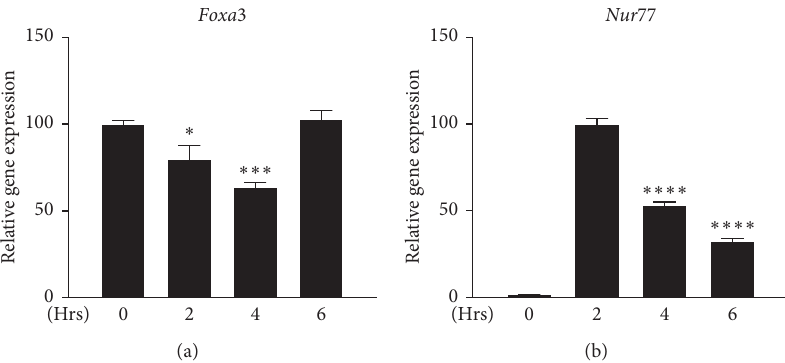
Figure 1: Expression of Foxa3 mRNA decreases during cAMP induction in MA-10 Leydig cells. Time-dependent expression of Foxa3 decreases up to 4 hours and is restored at 6 h (A), whereas the expression of Nur77 is strongly induced at 2h and then decreases (B) in cAMP-induced MA-10 cells. Nur77 expression at 2h and Foxa3 expression at 0h were considered 100% for relative comparison. The gene expression level was normalized to that of β -actin. For statistical significance, the t -test has been performed. ∗ P < 0 . 05; ∗∗ P < 0 . 01; ∗∗∗ P < 0 .